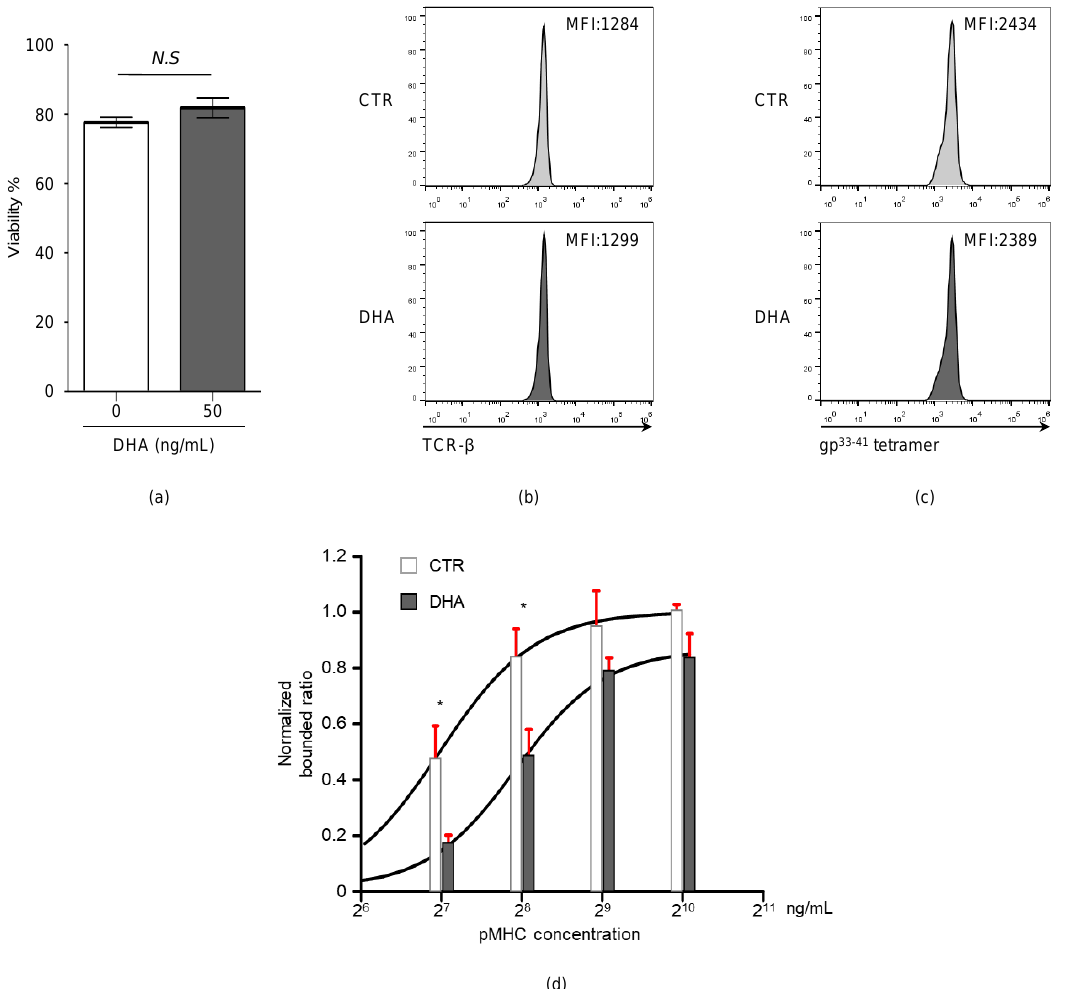
Figure 5. The extrinsic treatment with n -3 PUFA docosahexaenoic acid (DHA) decreases TCR-pMHC a ffi nity. The WT P14 cells were untreated (control, CTR) or treated with 50 µ M of DHA in the presence of 200 U / mL of IL-2 for 24 h. (a-c) Cell viability (% propidium iodide-negative cells) ( a ), the TCR expression ( b ), and gp 33-41 tetramer staining ( c ) were analyzed by flow cytometry. ( d ) The CTR or DHA-treated cells (2.0 × 10 5 cells) were loaded into pMHC-coated cells. After one hour of incubation, the attached cells were counted and normalized against the CTR P14 T cells (pMHC 1000 ng / mL condition). N.S , not significant; *, p <